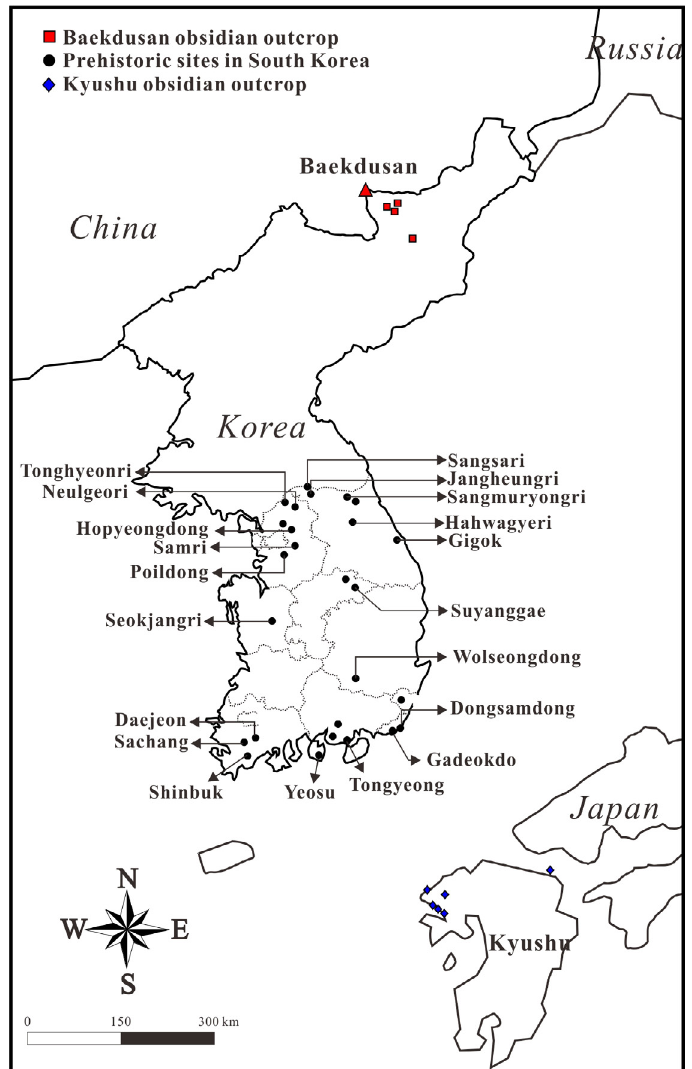
Figure 1. Major prehistoric obsidian localities in South Korea. Obsidian outcrops in Baekdusan and Kyushu are also indicated (Yi & Jwa,